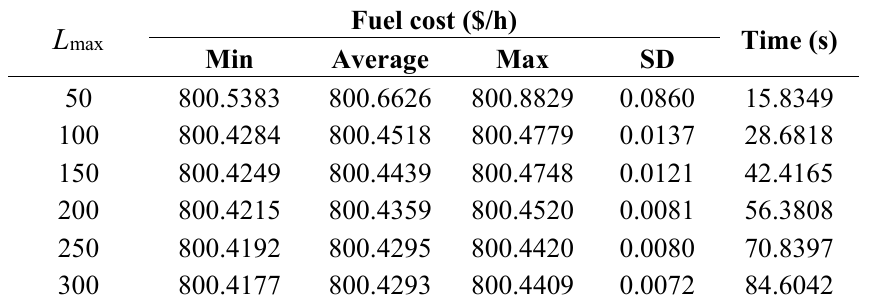
Table 3. Results obtained by the IABC algorithm with different L max values for OPF with total fuel cost.